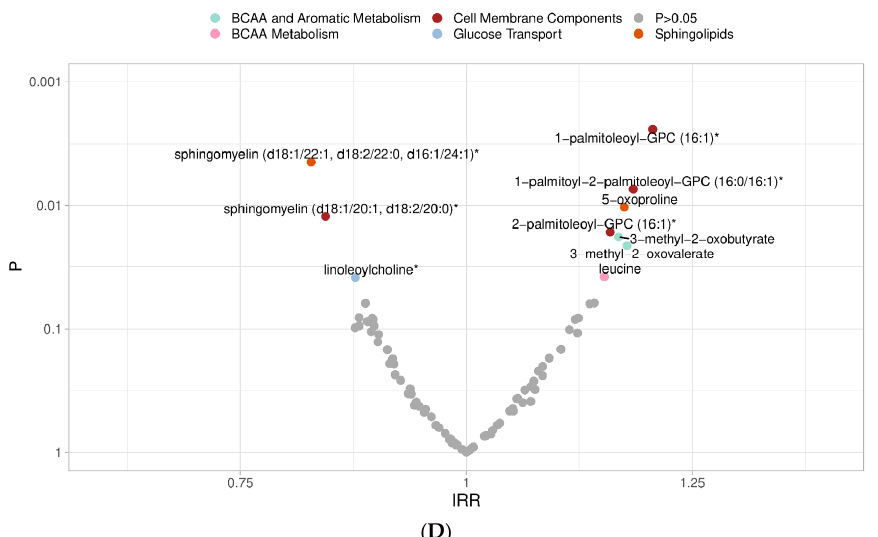
Figure 2. ( A ) Incidence rate ratios (IRR) and unadjusted p -values (P) for individual metabolites in relation to incident type 2 diabetes among all participants, according to their network-derived pathway. ( B ) Incidence rate ratios (IRR) and unadjusted p -values (P) for individual metabolites in relation to incident type 2 diabetes among those with prediabetes at baseline, according to their network-derived pathway. ( C ) Incidence rate ratios (IRR) and unadjusted p -values (P) for individual metabolites in relation to incident prediabetes among participants with normal glycemic levels at baseline, according to their network-derived pathway. ( D ) Incidence rate ratios (IRR) and p -values (P) for individual metabolites in relation to incident prediabetes or type 2 diabetes among all participants, according to their network-derived pathway. Metabolites with unadjusted p -values < 0.05 are colored according to their network-derived cluster membership; metabolites with FDR-adjusted p -values < 0.05 are indicated with a triangle-shaped marker.